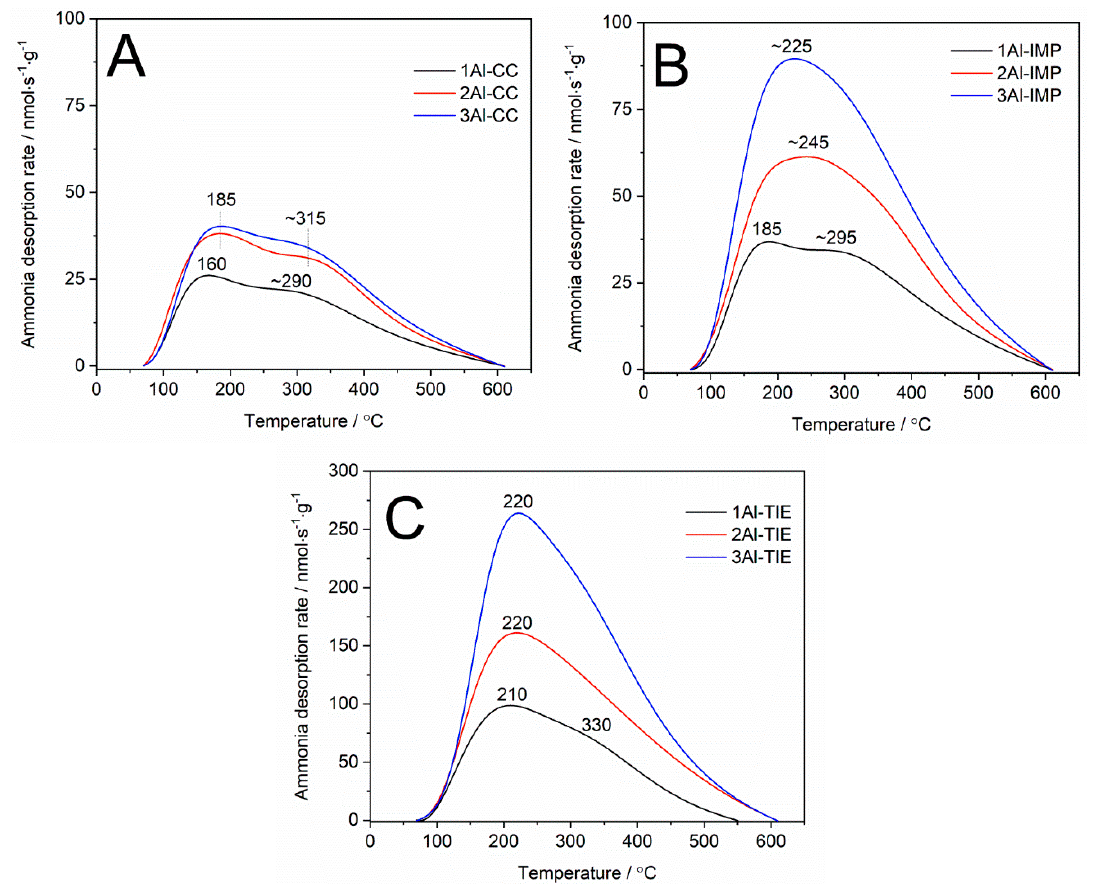
Figure 4. NH 3 -TPD profiles of MCM-41 modified with aluminum by co-condensation ( A ), impregnation ( B ) and TIE ( C ) methods.